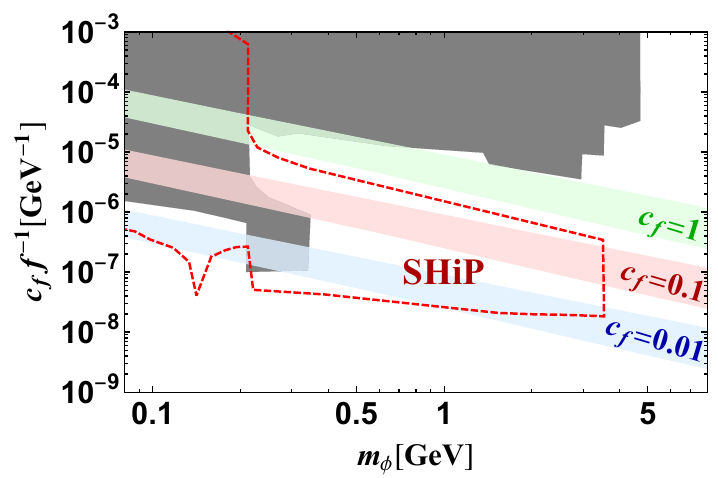
Figure 5 . The parameter region predicted by the ALP inflation ( n = 2) with Yukawa-like couplings to all the SM fermions. The green, red, and blue bands correspond to c respectively from top to bottom. The red dashed line denotes the sensitivity reach of the SHiP experiment, and the gray region is excluded by other experiments